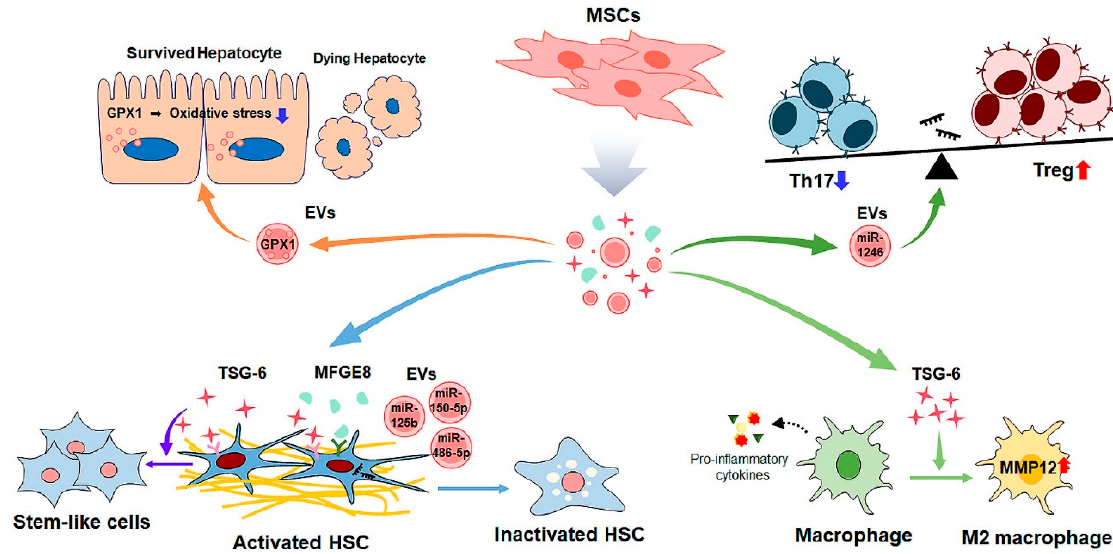
Figure 3. Therapeutic strategy of MSC-derived secretome and EVs for liver fibrosis. MSCs-derived secretome and extracellular vesicles (EVs) have therapeutic potential for liver fibrosis. In hepatocyte, MSCs-EV delivering glutathione peroxidase 1 (GPX1) reduces oxidative stress, and inhibits hepatocyte death, attenuating liver fibrosis. Several cytokines and EVs targeting HSC also ameliorate liver fibrosis. Tumor necrosis factor-inducible gene 6 protein (TSG-6) induces trans-differentiation of activated HSCs into stem-like cell. Milk Fat Globule EGF Factor 8 protein (MFGE8) and MSCs-EV carrying microRNA (miR) such as miR-486-5p, miR-150-5p and miR-125b reduce liver fibrosis through inactivating HSCs. In addition, MSC-EVs regulate the proportion of T cell by decreasing T helper 17 (Th17) cells and increasing regulatory T (Treg) cells. In macrophage, TSG-6 triggers polarization of M2 macrophage and upregulates MMP12 which suppresses HSC activation.